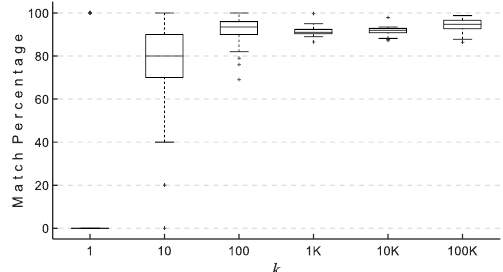
Figure 5 Match percentage of Postgres-v2 and MongoDB MongoDB and Postgres-v2 match only on six points out of 30 randomly chosen points when k equals to one. These points defined as outliers because the matching rate is zero. The median match percentages increase from 80% to 94.8% as k increases from 10 to 100K. However, the increment in the match percentages are not linear and when k =1K, it becomes 91.05%. Even though, the match percentages are quite high for 𝑘 ≥ 10 , it is still important to highlight the distinction between the detected nearest neighbours. The results indicate that there the detected neighbours for the same point might vary depending on the DBMS. Therefore, it is important to determine which one to rely on when spatial accuracy is considered. Recall that V(𝑝,𝑥 𝑘𝑃 ) and V(𝑝, 𝑥 𝑘𝑀 ) denote the Vincenty distance between the query point p to its most distant nearest neighbour in Postgres and MongoDB respectively. Our empirical results suggest that there is no significant difference between Haversine and Vincenty distance functions because points are very close to each other. Therefore, Vincenty distance function is preferred to determine the spatial accuracy as it is more accurate compared to the Haversine function (Mahmoud and Akkari